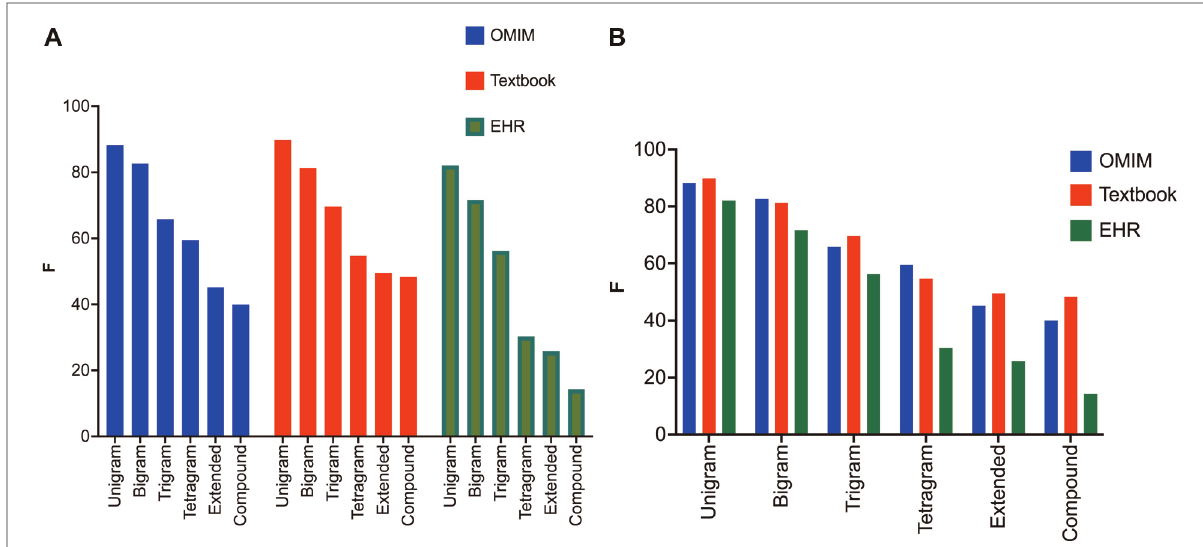
FIGURE 3 ( A ) F values for the BERT NER model sorted by text span label type. The BERT NER model performs similarly on the three corpora for unigrams and bigrams, but F values lag for the EHR corpora for the tetragrams, extended text spans, and compound text spans. Note that the BERT NER model performs signi fi cantly worse on the EHR corpus for tetragrams, extended text spans, and compound text spans when compared to the Textbook or OMIM corpus. ( B ) F values for the BERT NER model sorted by corpus. All three corpora show the same pattern with declining F values with the increasing length of the text